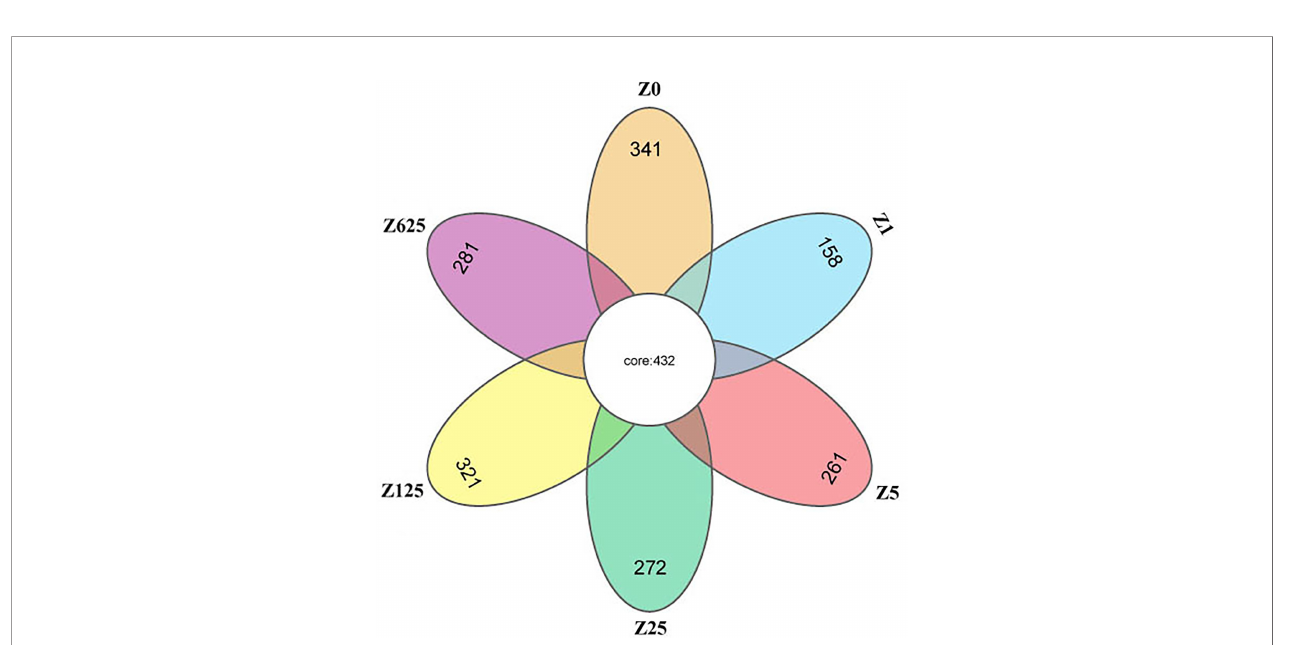
FIGURE 4 | Effect of different levels of zymosan-A on the expressions of trypsin , lipase , and amylase genes in the intestine of Litopenaeus vannamei . Different letters indicate signi fi cant differences between treatments ( p < 0.05).